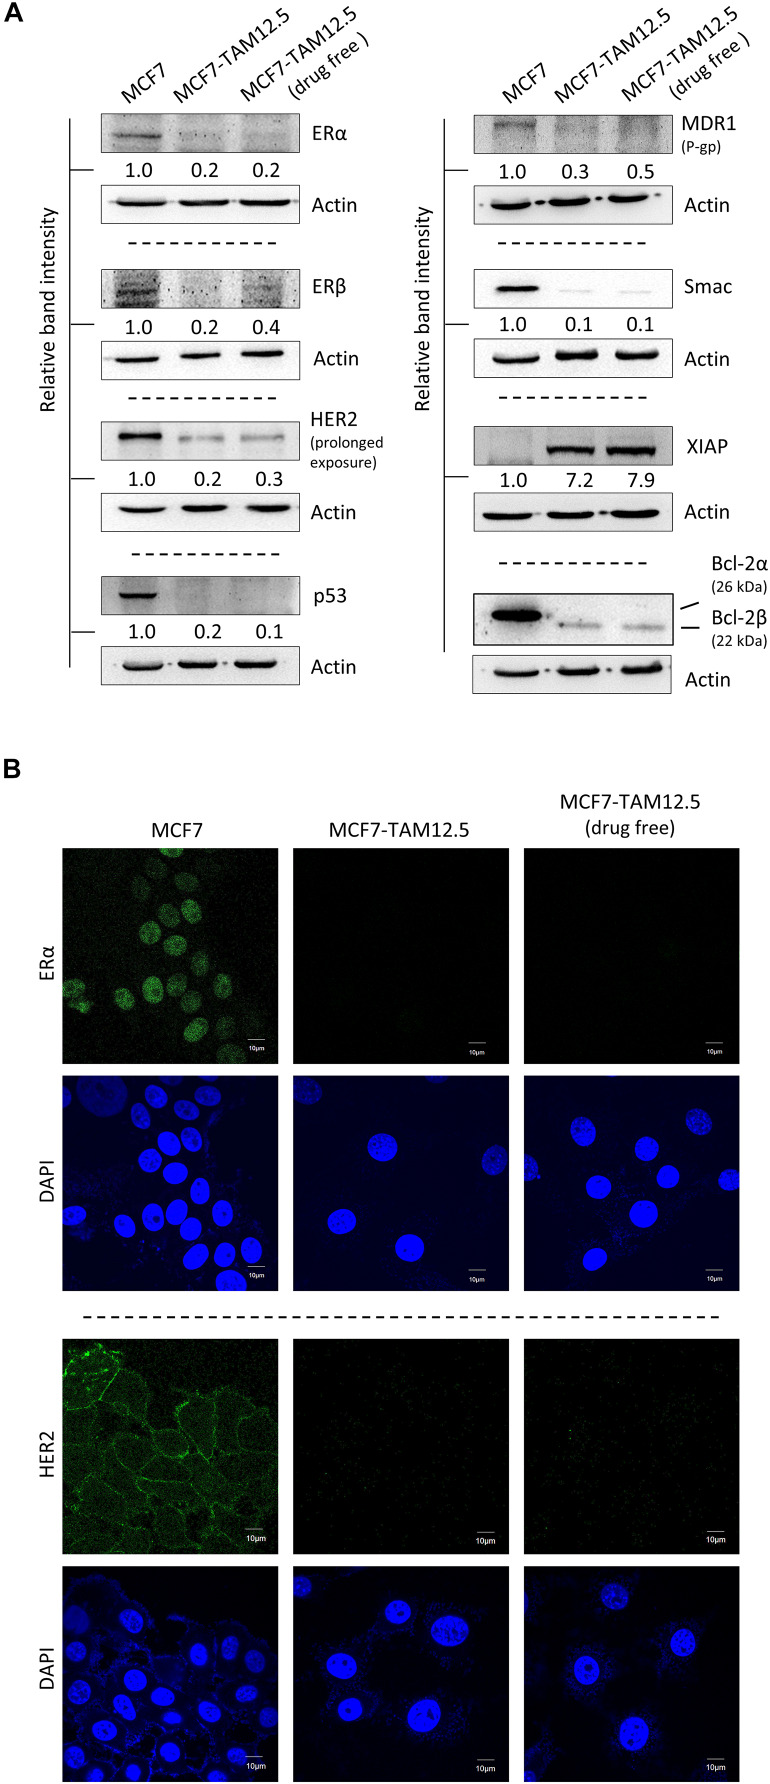
Molecular characterizations of MCF7 and MCF7-TAM12.5 cells. (A) Protein expression level of ERα, ERβ, HER2, p53, MDR1, Smac, XIAP, and Bcl-2 was analyzed in MCF7, MCF7-TAM12.5 (under 12.5 μM tamoxifen), and MCF7-TAM12.5 (drug free) cells by Western blotting. Equal protein loading was verified by actin. The numbers under each blot are the intensities of the blot relative to MCF7 cells. (B) Location of ERα and HER2 (green fluorescence) was visualized by immunofluorescence microscopy. Nuclei were counterstained blue by DAPI.